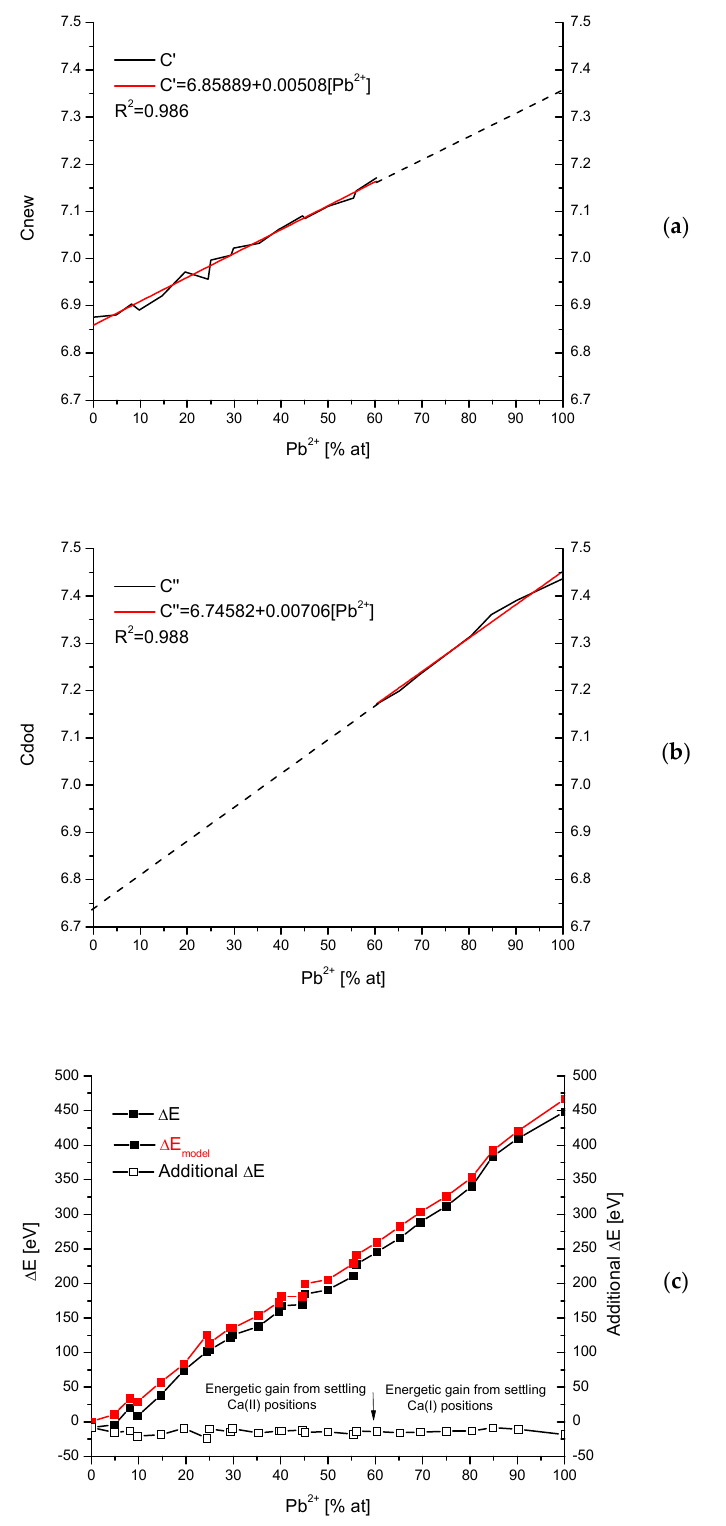
Figure 6. ( a ) Approximation and hypothetical prolongation of the first increment of “c” values for Ca-Pb hydroxyapatite system; ( b ) the same for second increment; ( c ) energy loss spectrum for Ca-Pb substitutions in hydroxyapatite, real (black) and hypothetic (red) one, and the spectrum of energy differences (open squares) resulting from the energetic nonequilibrium of positions Ca(I) and Ca(II). Basic data from positions